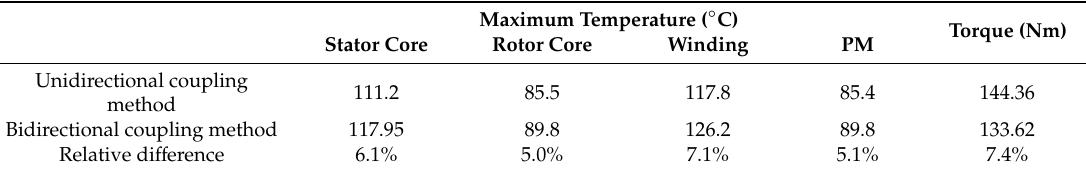
Table 8. The highest temperature of each component.